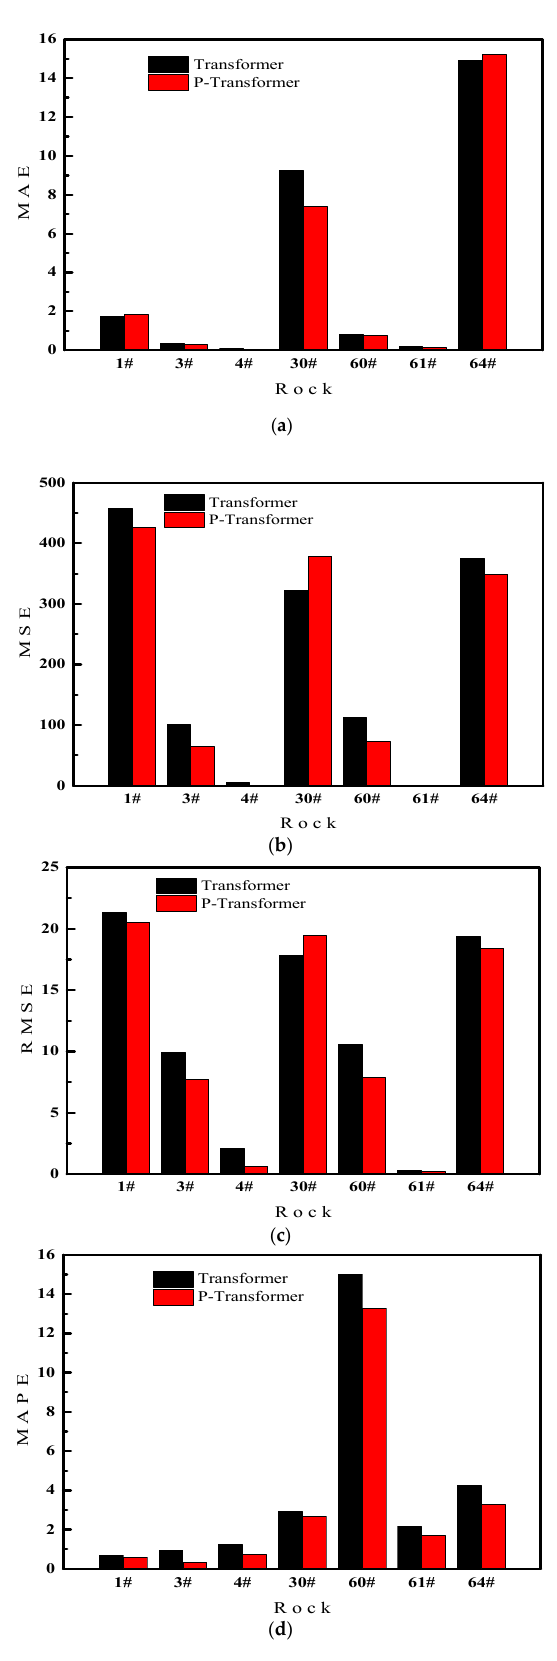
Figure 6. The metric results of the P-Transformer and Transformer algorithms: ( a ) MAE; ( b ) MSE; ( c ) RMSE; ( d ) MAPE.